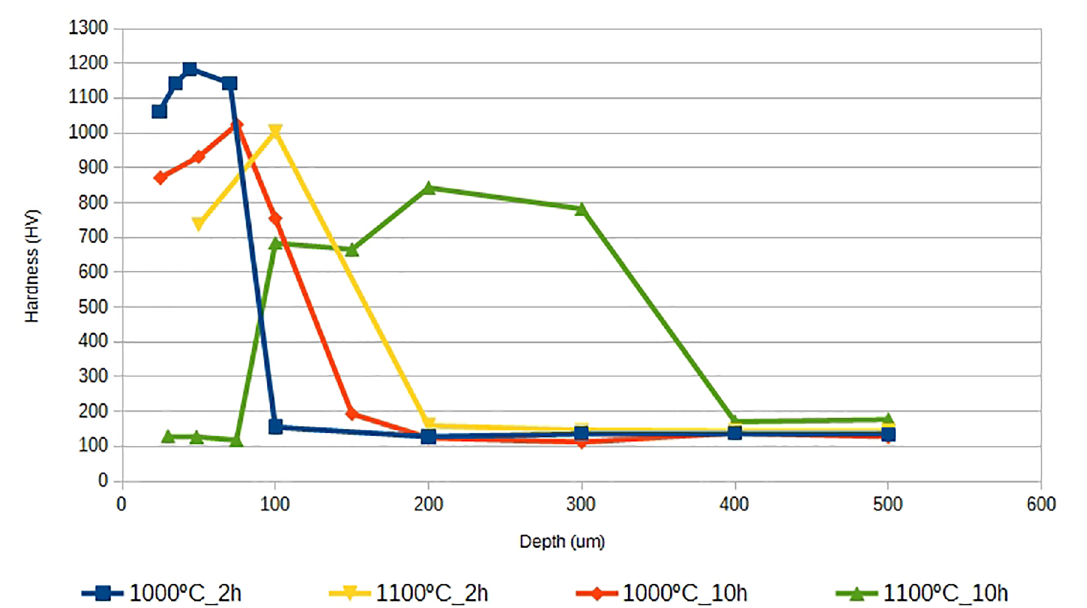
Figure 2. Hardness profiles of the borided AISI 1020 steel at 1000º C/ 1100º C for 2h and